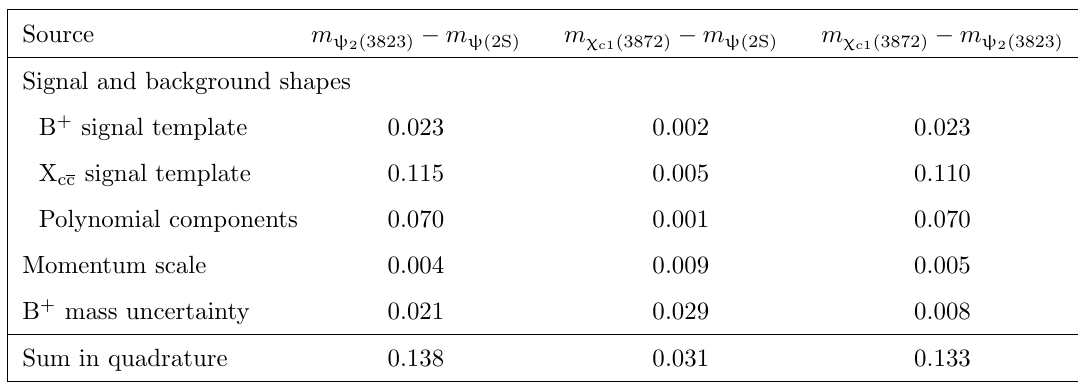
Table 3 . Systematic uncertainties (in MeV/ c 2 ) for the mass splitting between the 2 (3823), (cid:31) c1 (3872) and (2S)